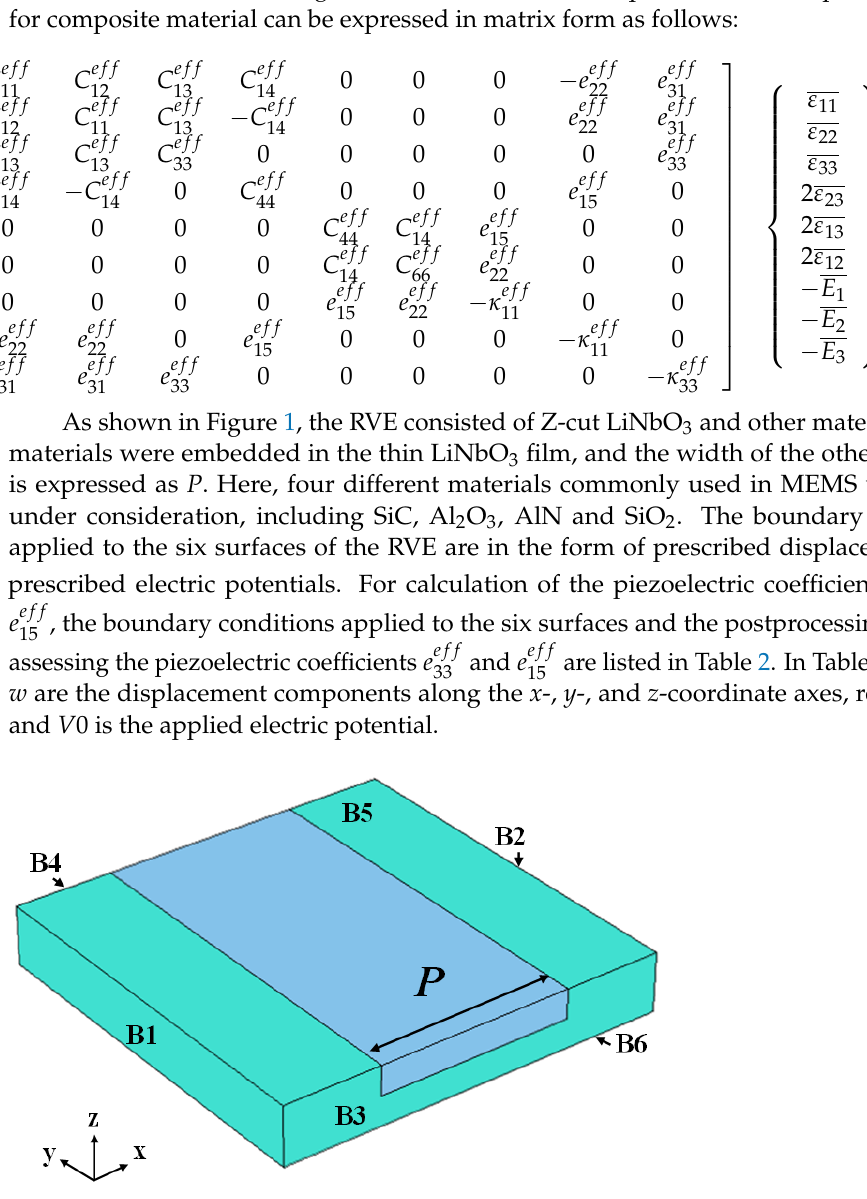
Figure 1. Images of full representative volume elements (RVEs). The green regions represent the LiNbO3 material, whereas the blue region represents the other material. Table 2. Boundary conditions for evaluating the effective properties of the composite.